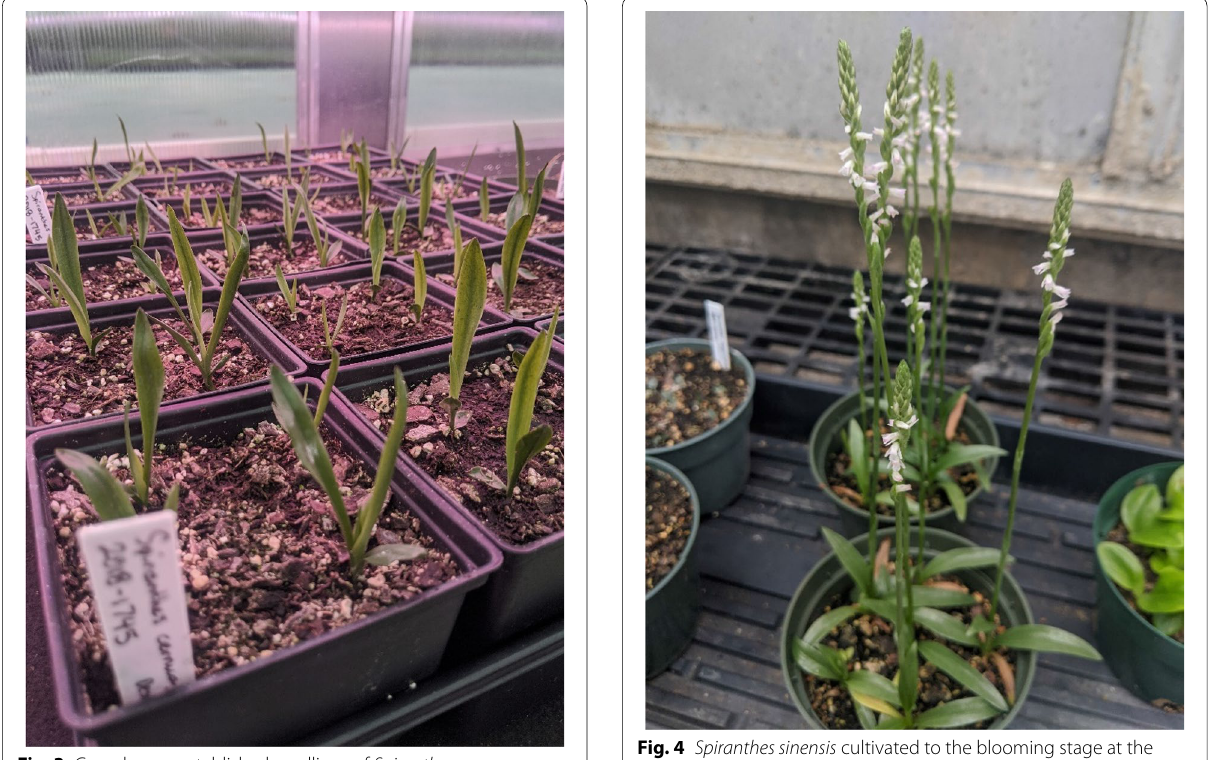
Fig. 3 Greenhouse-established seedlings of Spiranthes cernua on soil after being vernalized at 4 °C prior for three months in darkness. These seedlings initiated anthesis after 421 days (331 days in lab culture plus 3 months in vernalization)